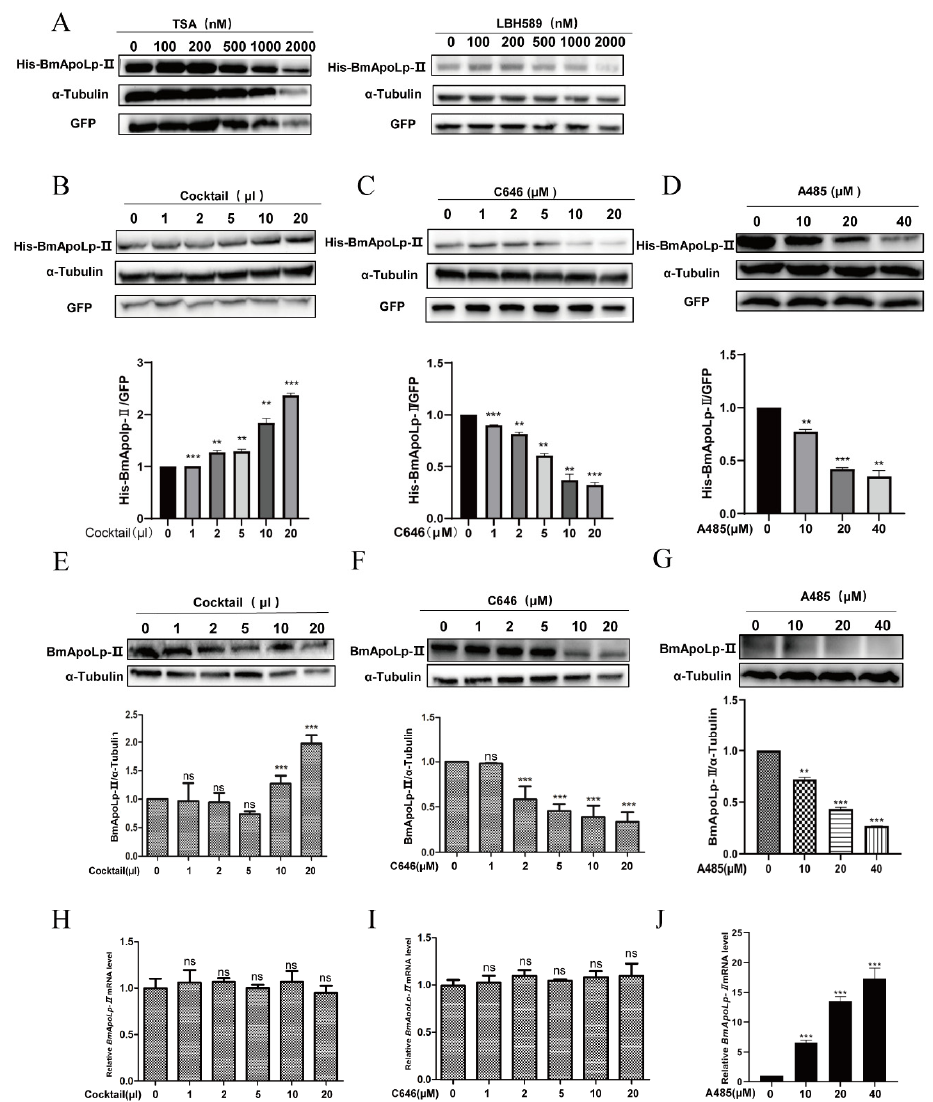
Figure 3. Acetylation up-regulates the expression of BmApoLp-II protein. ( A ) Compared with the co-expressed GFP protein, there was no significant effect on the expression of BmApoLp-II in BmN cells treated with different concentrations of TSA (left) or LBH589 (right). ( B ) Compared with the co-expressed GFP protein, the expression of BmApoLp-II protein increased significantly with the increase of cocktail usage. ( C ) Compared with the co-expressed GFP protein, the expression of BmApoLp-II showed a significant downward trend after C646 treatment. ( D ) Compared with the co-expressed GFP protein, the expression of BmApoLp-II showed a significant downward trend after A485 treatment. ( E ) The cells were treated with different concentrations of cocktail, and the expression of endogenous BmApoLp-II protein also showed an upward trend. ( F ) C646-treated cells showed a downward trend of endogenous BmApoLp-II protein expression. ( G ) A485-treated cells showed a downward trend of endogenous BmApoLp-II protein expression. ( H ) The transcriptional level of BmApoLp-II did not change meaningfully after treatment with cocktail. ns: no significance. ( I ) The transcriptional level of BmApoLp-II did not change meaningfully after treatment with C646. ns: no significance. ( J ) The treatment of A485 up-regulated the mRNA level of BmApoLp-II gene. The data represent the results of at least three independent experiments. ns: no significance, ** p < 0.01, *** p <